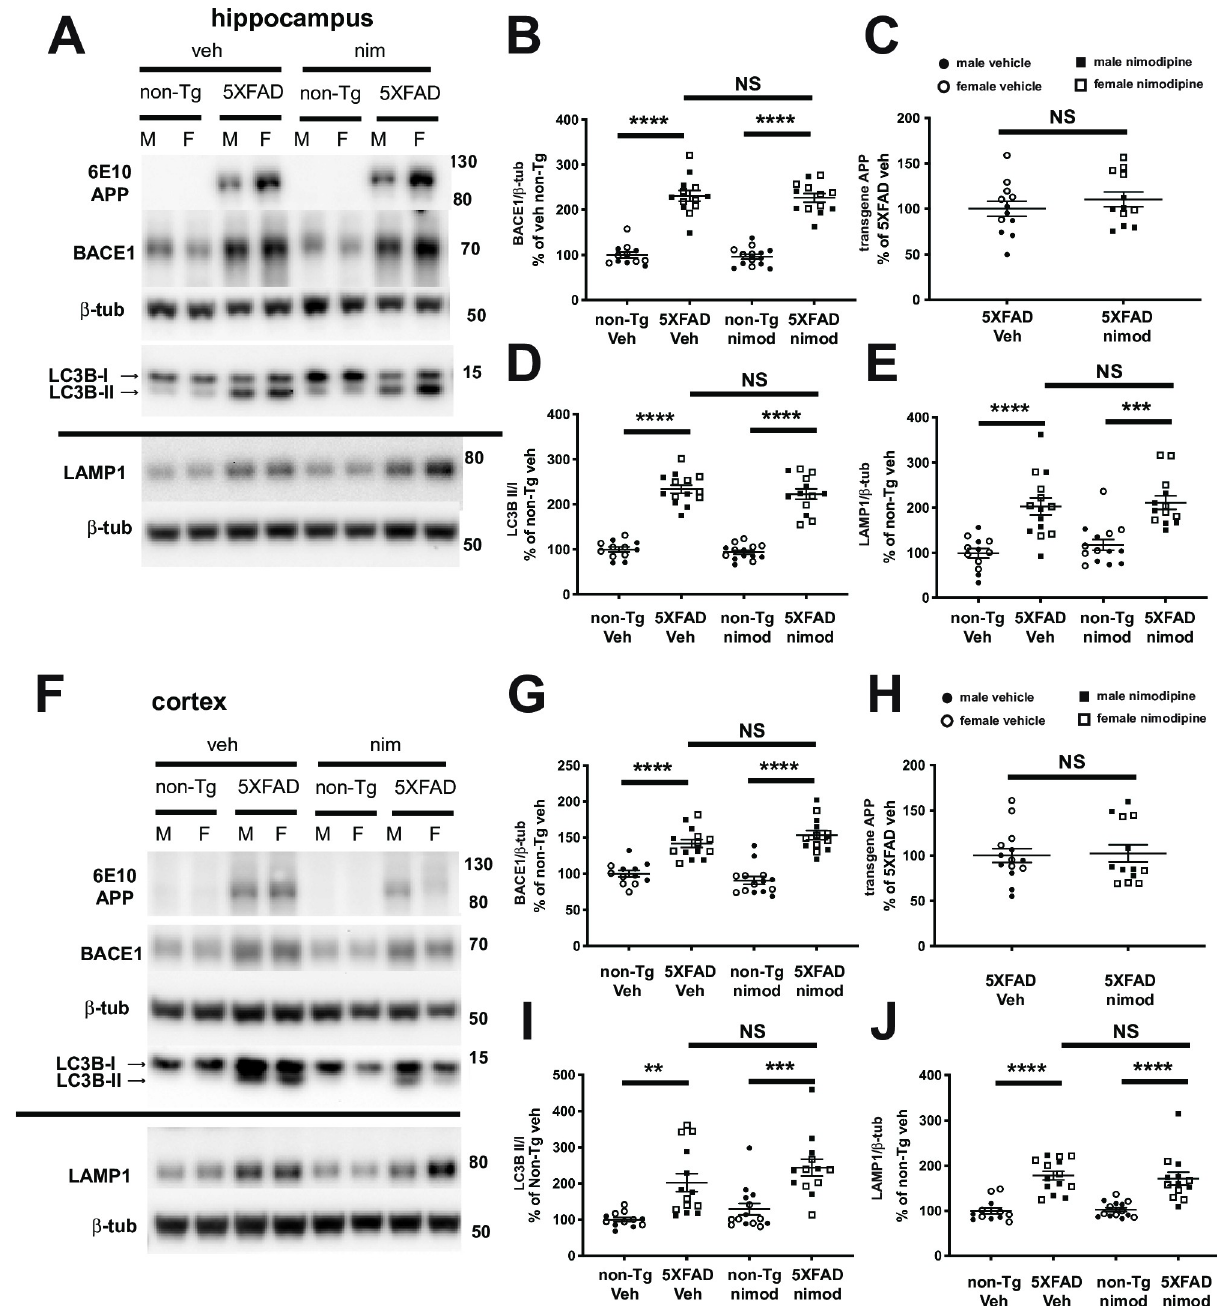
Fig 2. Nimodipine does not decrease markers of neuritic dystrophy in 5XFAD transgenic mice. ( A and F) Representative immunoblots of hippocampal (A) and cortical (F) lysates of non-transgenic and 5XFAD mice treated with vehicle or nimodipine. (B-E and G-J) Quantification of BACE1 (B, G), transgenic APP (C, H), LAMP1 (E, J) (all normalized to β -tubulin) and LC3B-II/ LC3B-I (D, I). As expected, BACE1, LAMP1 and LC3B-II/ LC3B-I were elevated in vehicle-treated 5XFAD compared to vehicle non-transgenic mice. Similarly, BACE1, LAMP1 and LC3B-II/ LC3B-I were also increased in nimodipine-treated 5XFAD compared to nimodipine treated non-transgenic mice, indicating that nimodipine did not decrease the accumulation of these dystrophic neurite marker proteins. Nimodipine had no effect on expression of transgenic human APP. F, female; M, male; � 0.05 > p > 0.01 �� 0.01 > p > 0.001 ��� 0.001 > p > 0.0001; ���� 0.0001 > p; Error bars = S.E.M.